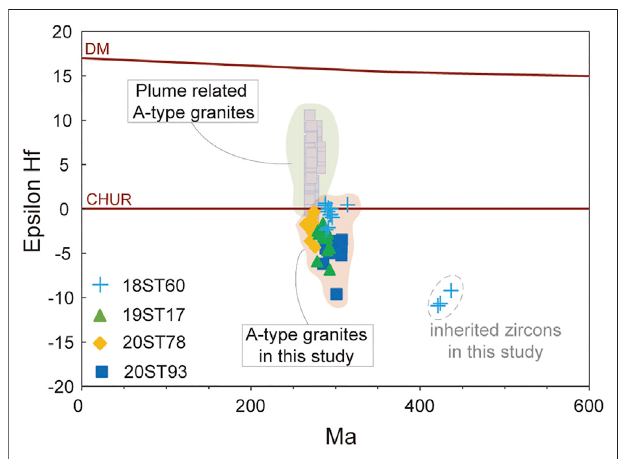
FIGURE 5 | Temporal variations of zircon ε Hf (t) values showing the contrasting difference in the magma source between the Permian A-type granitoids in the South Tianshan that mostly have negative ε Hf (t) values (Supplementary Table S3) and the Permian Tarim plume-related A-type granites that have apparent positive ε Hf (t) values (data sources are can be found in Su et al., 2019; Wei et al., 2019; Zhang et al.,